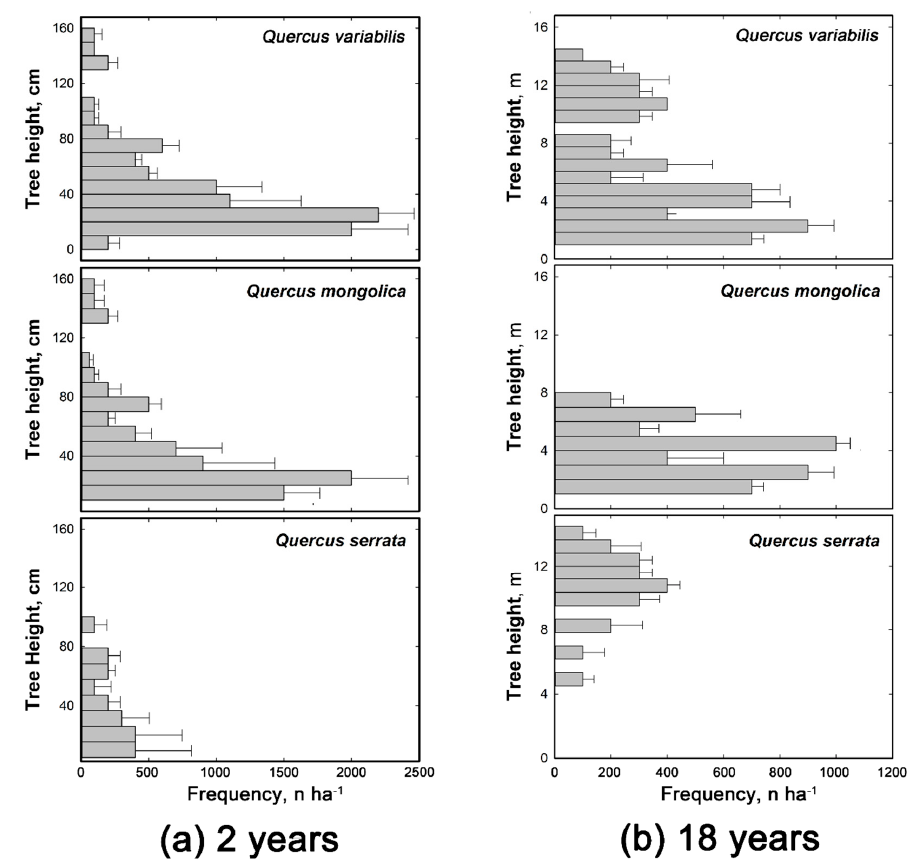
Figure 2. Change to the vertical distribution of oak species. in Q. serrata (glandbearing oak) stands as time passed. ( a ) 2 years after the forest fire; ( b ) 18 years after the forest fire. Error bar means standard error.